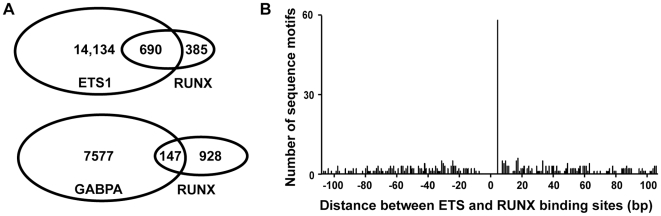
ETS1/RUNX co-occupancy correlates with specific spacing of ETS and RUNX binding sites.(A) Overlap of ETS1/RUNX and GABPA/RUNX bound regions. The RUNX antibody was raised against the conserved DNA binding domain and does not differentiate between the homologous RUNX1 and RUNX3 proteins present in T cells (N. Speck unpublished observation). (B) Spacing of ETS and RUNX binding sites in ETS1/RUNX co-occupied regions. The 690 ETS1 bound regions that were co-occupied by RUNX were scanned for matches to the in vitro derived position weight matrixes for ETS1 (M00032) and RUNX (M00271) from the Transfac database (http://www.biobase-international.com/index.php?id=transfac). For each ETS1 sequence found, the distance to all forward oriented RUNX sequences in the same region were determined such that a RUNX site 5′ to an ETS site in the orientation CCGGAAGT was negative and 3′ was positive. A similar mapping of RUNX sites in the reverse orientation returned no spacing frequencies higher than five. The prominent peak at a spacing of five bp correlates with the spacing and orientation in the composite sequence CAGGATGTGGT, from Motif 4 (Figure 3).